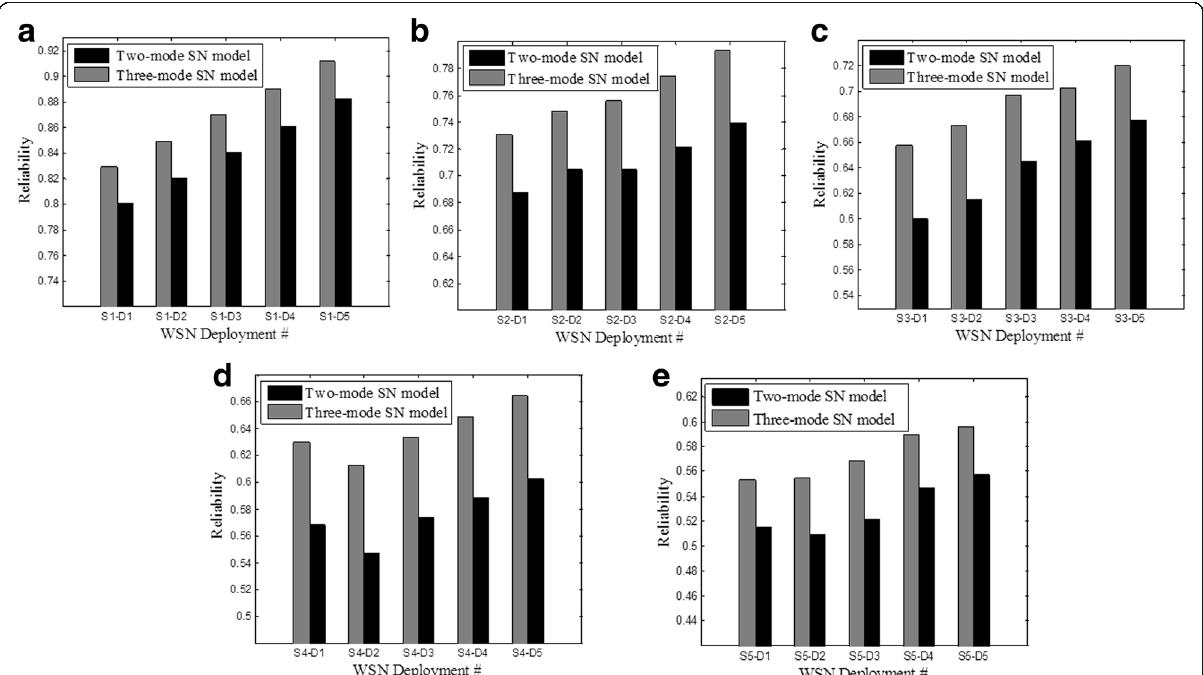
Fig. 6 Comparison between the reliability of WSN deployments in Table 4 evaluated using the proposed three-mode SN model and the two-model SN model adopted in existing studies in [8], [11], [14], and [16] for the deployment scenarios 1 through 5 ( a – e